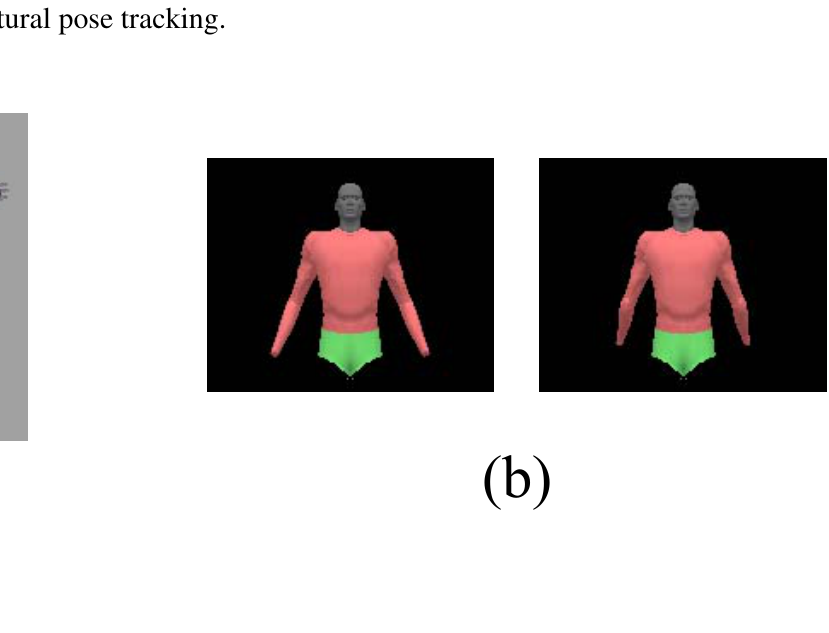
Figure 2. Human body model (a) Hierarchical joint link model with 28 dofs; (b) Elbow joint limit constraints for natural pose